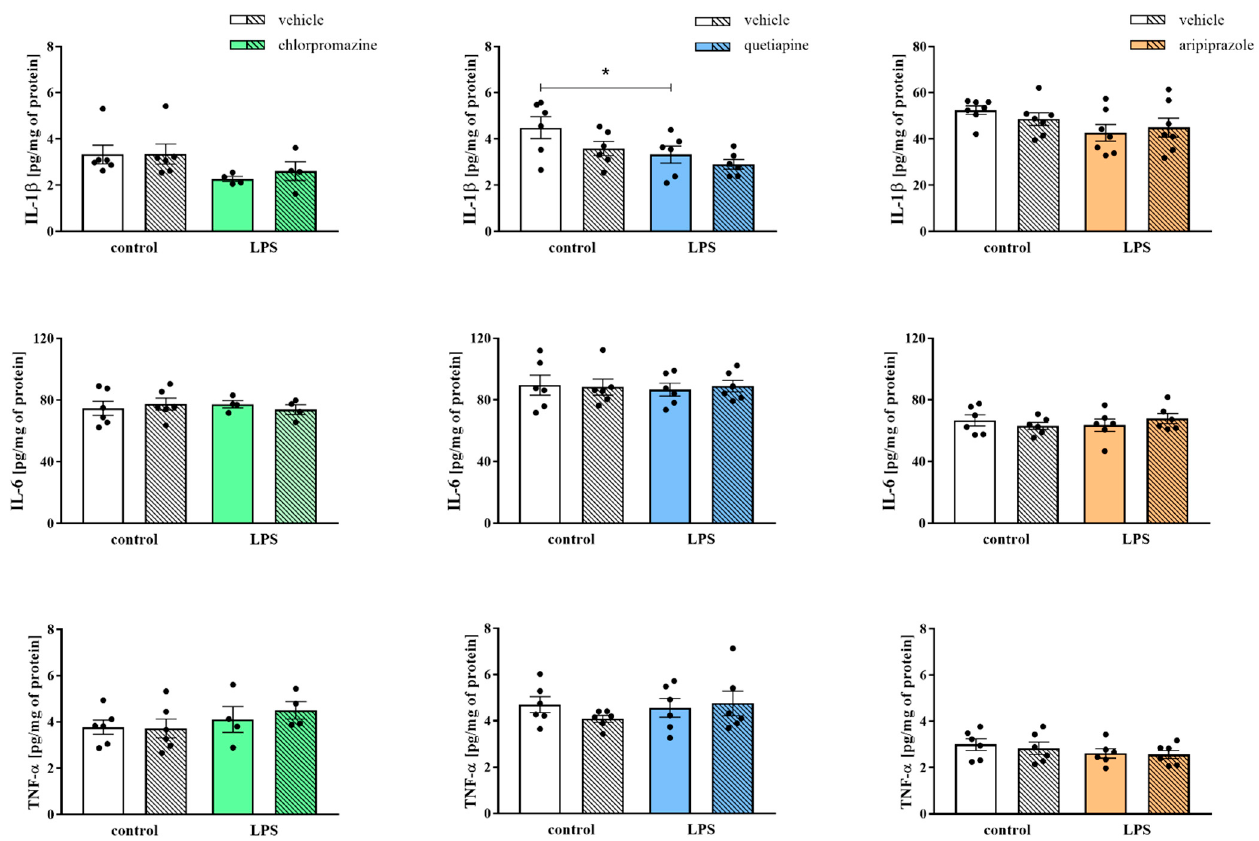
Figure 3. The impact of prenatal exposure to LPS and subsequent chronic treatment with chlorpromazine ( n = 4–6 in each group), quetiapine ( n = 6 in each group) or aripiprazole ( n = 6–7 in each group) on the levels of the proinflammatory proteins (IL-1 β , IL-6 and TNF- α ) in the frontal cortices of the offspring. The results are presented as the mean ± SEM. * p < 0.05 vs. control +